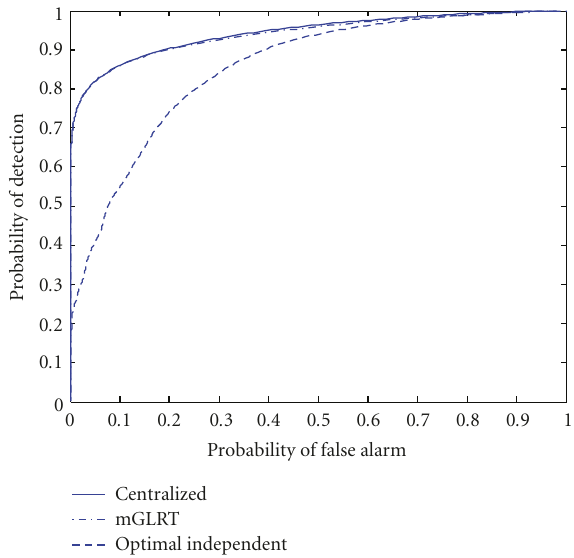
Figure 10: ROC curve of the mGLRT with a 2/3 censoring probability and the optimal independent test for the frog detection